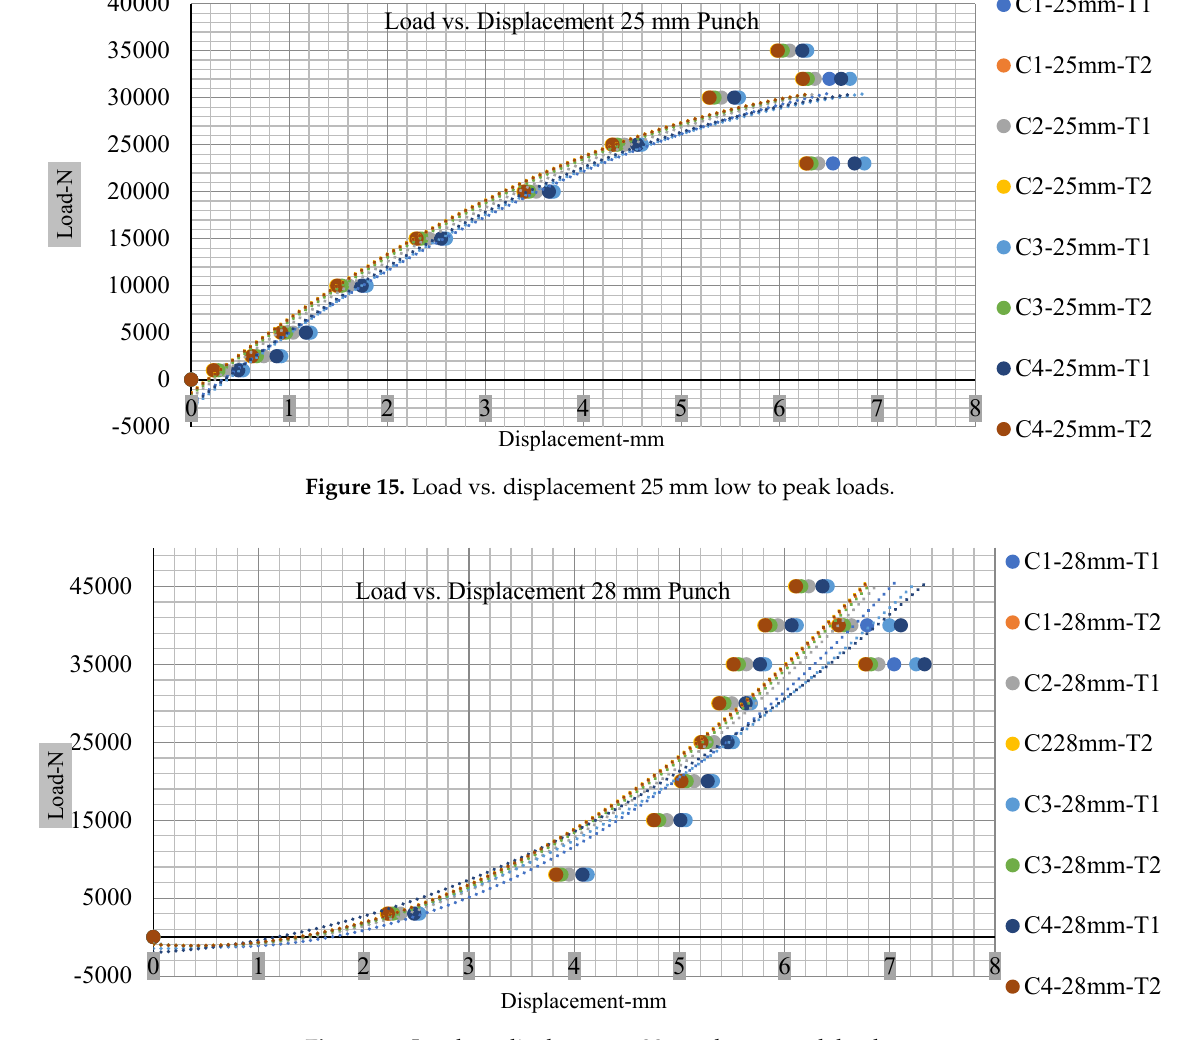
Figure 16. Load vs. displacement 28 mm low to peak loads.